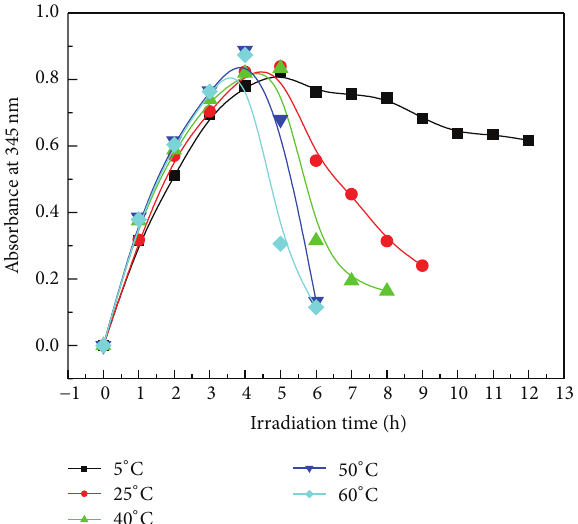
Figure 6: Absorbance at 345 nm as a function of irradiation time for SA + PAH solution (0.062 g/L, pH 10). UV-B irradiation (306 nm, 15.0 mW).